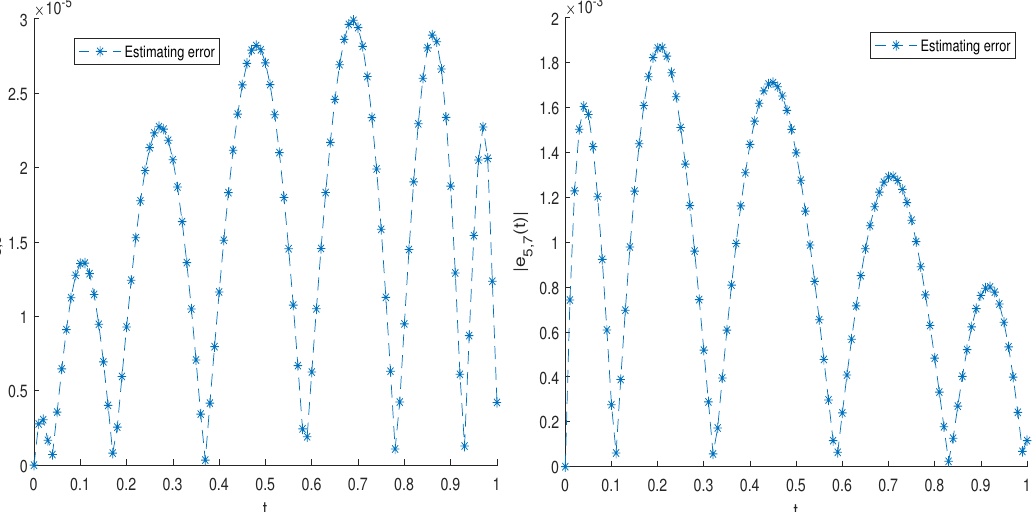
Figure 15. The estimation of absolute error for Example 5, for ( N , M ) = ( 5,7 ) and ( N , M ) = ( 8,9 ) with ν =